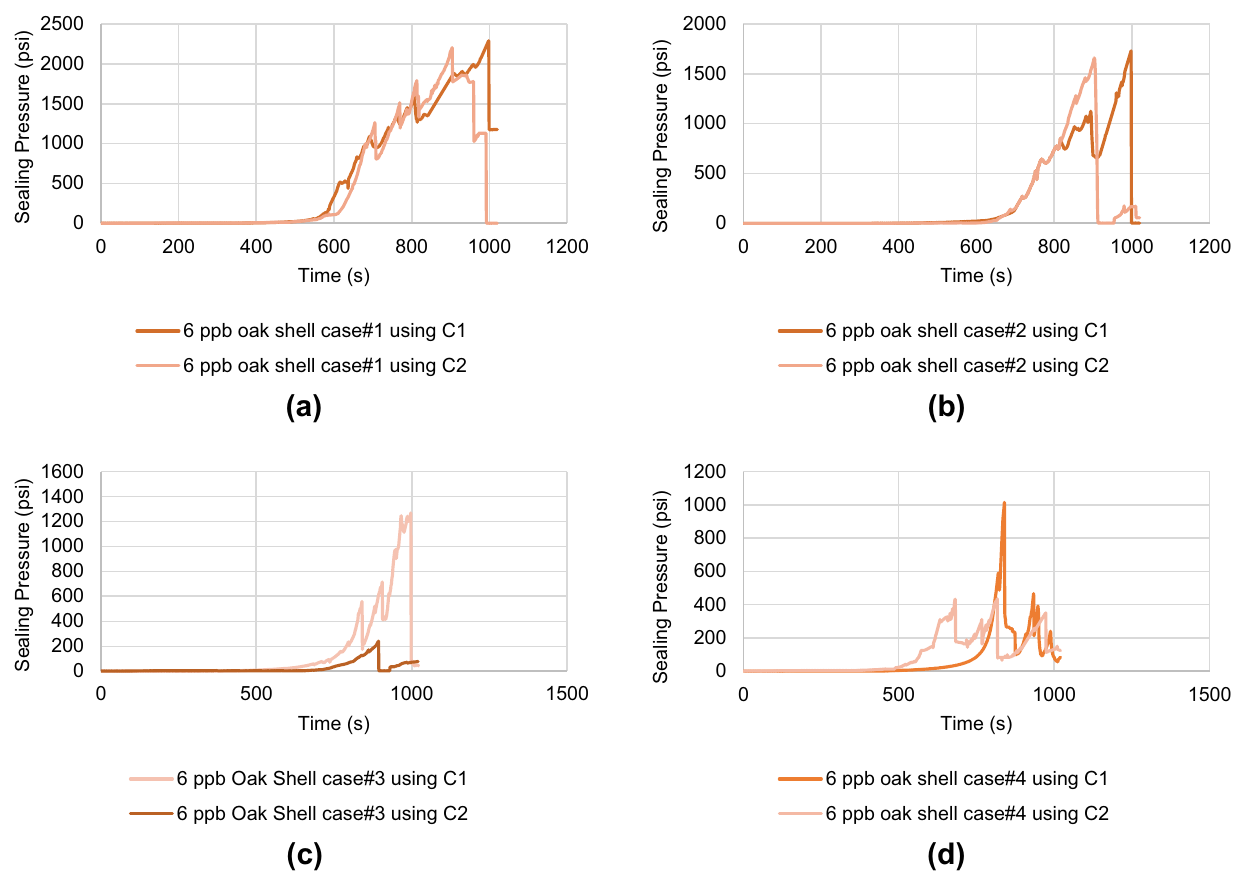
Fig. 24 HPA Pressure vs. Time plot for 6 ppb Oak Shell showing maximum sealing pressure at different fracture widths, a case#1, b case#2, c case#3, d